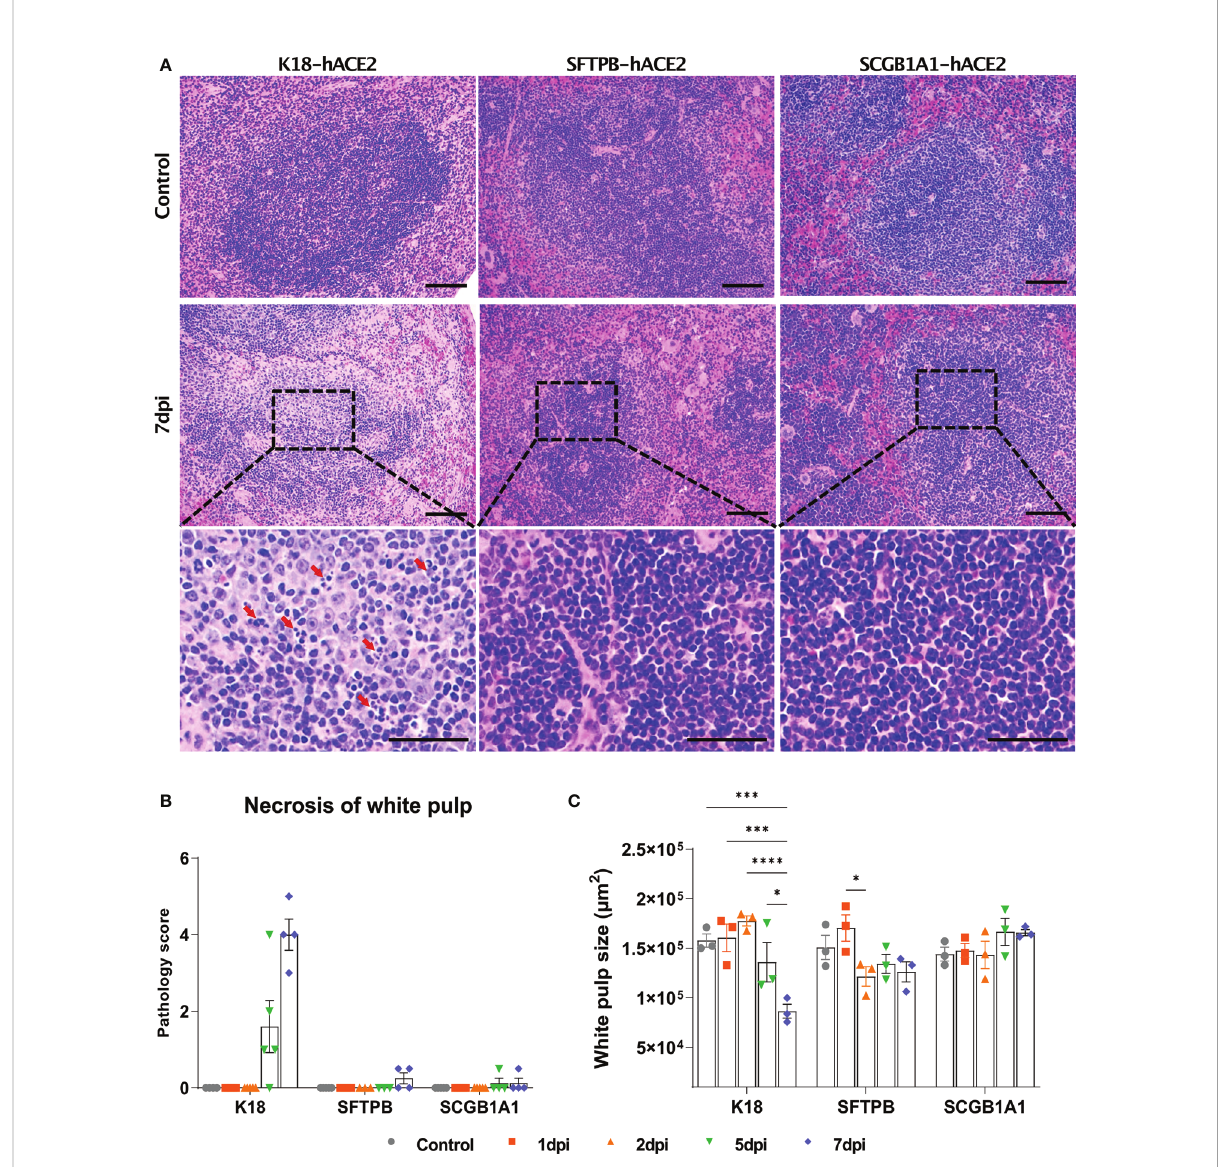
FIGURE 5 Pathological analysis and scoring of the spleen in SARS-CoV-2-infected K18-hACE2, SFTPB-hACE2, and SCGB1A1-hACE2 mice. (A) H&E staining of the spleen following injection with PBS (control, top panels) or 1 ×10 5 PFU SARS-CoV-2. SARS-CoV-2 at 7 dpi (middle panels) and enlarged image (bottom panels). The scale bars are 100 m m (top and middle panels) and 50 m m (bottom panels). (B) Spleen pathology scoring of SARS- CoV-2-infected animals and mock-infected controls at 1, 2, 5, and 7 dpi. The severity score ranges from 0 to 5 (0 = none; 1 = weak; 2 = mild; 3 = moderate; 4 = severe; 5 = markedly severe). (C) White pulp size of SARS-CoV-2 infected with each animal in the non-infected control at 1, 2, 5, and 7 dpi. (* P < 0.05; *** P < 0.001; **** P <